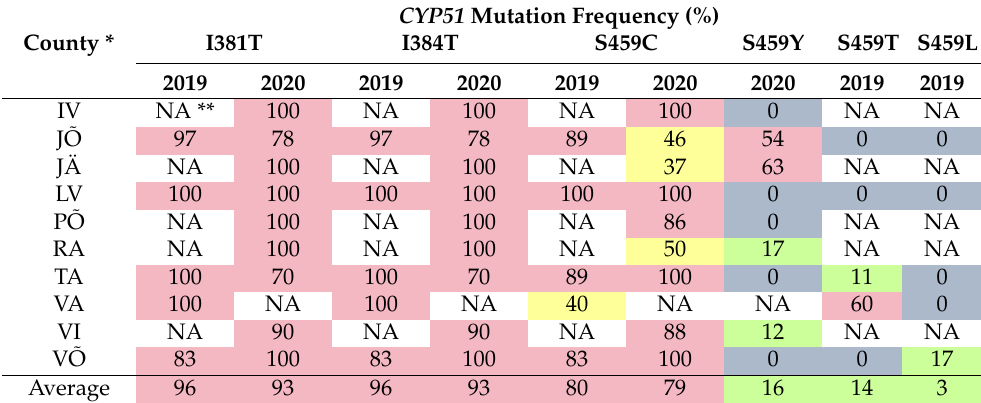
Table 2. CYP51 mutation frequencies (%) in R. collo-cygni population from Estonia in 2019 and 2020. Frequencies between 1 ‒ 20% are indicated in green, 21 ‒ 50% are yellow, 51 ‒ 100% are pink, missing mutations (0%) are grey.